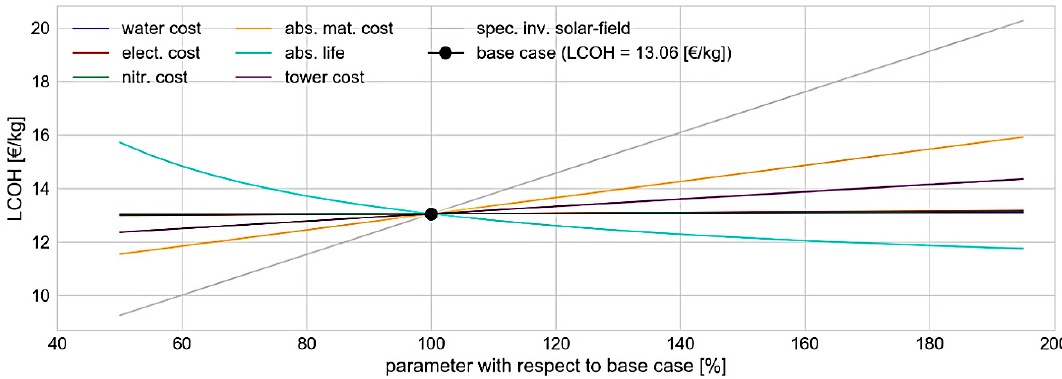
Figure 10. Sensitivity analysis of LCOH (ceria, base case).